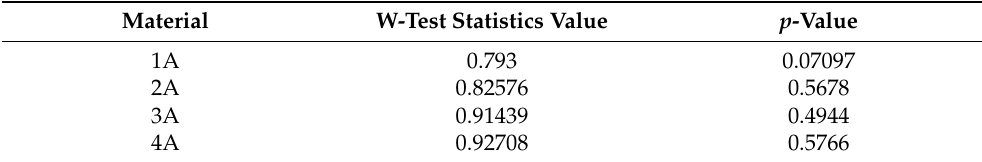
Table 7. S-W test results for individual materials.